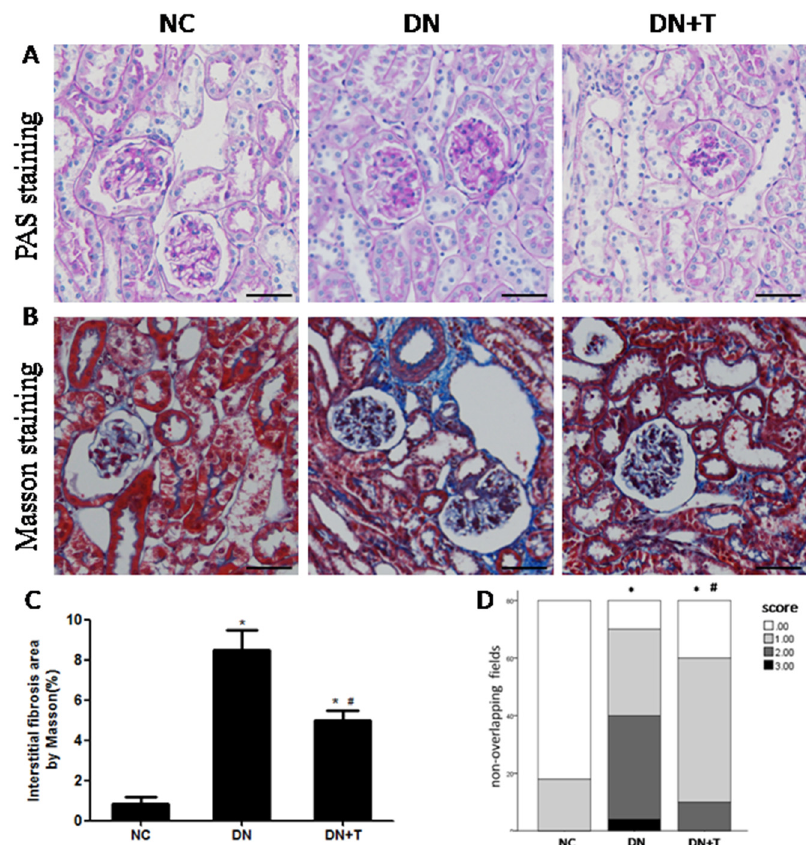
Figure 2. Histological analysis of kidney. Representative sections from kidneys of mice from each group at 16 weeks of age and stained with: ( A ) PAS (original magnification, 200×); and ( B ) Masson’s trichrome. Scale bar = 50 μ m; Quantitive analysis of interstitial fibrosis area ( C ); and tubulointerstitial injury ( D ). Normally distributed data were expressed as means ± SEM whereas categorical variables were described as frequencies for 10 non ‐ overlapping fields of each section and eight mice per group * p < 0.05 versus NC group. # p < 0.05 versus DN group.